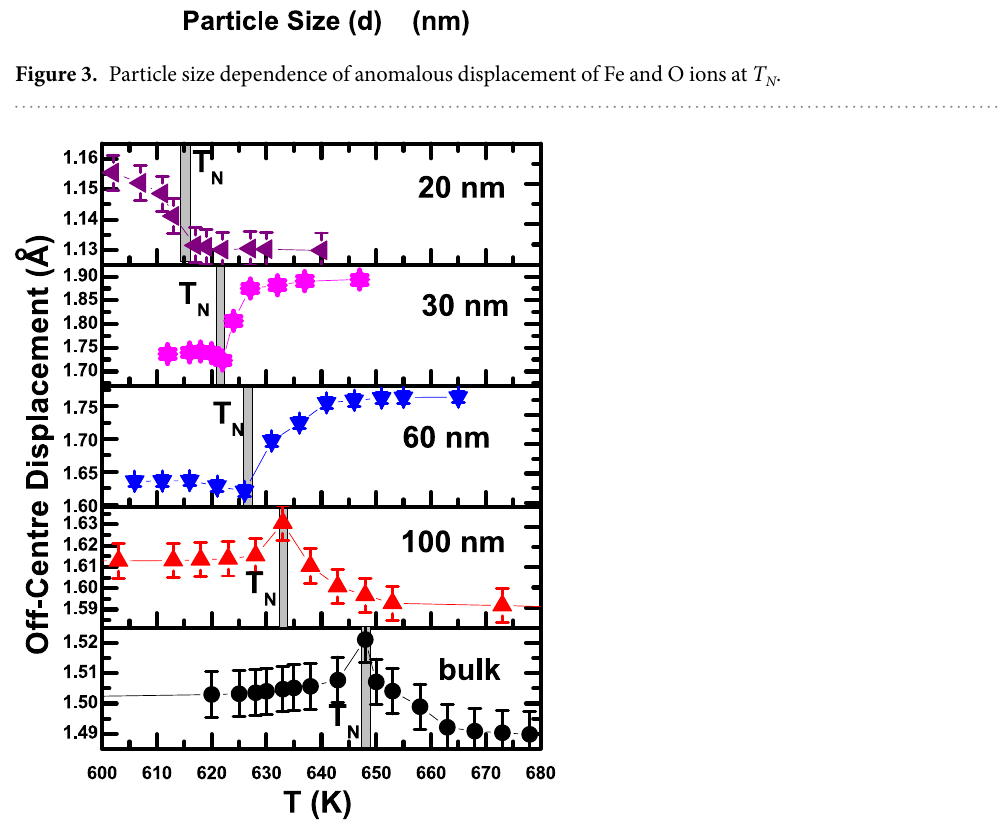
Figure 4. Variation of off-centre displacement within a unit cell with temperature across T N for a few representative